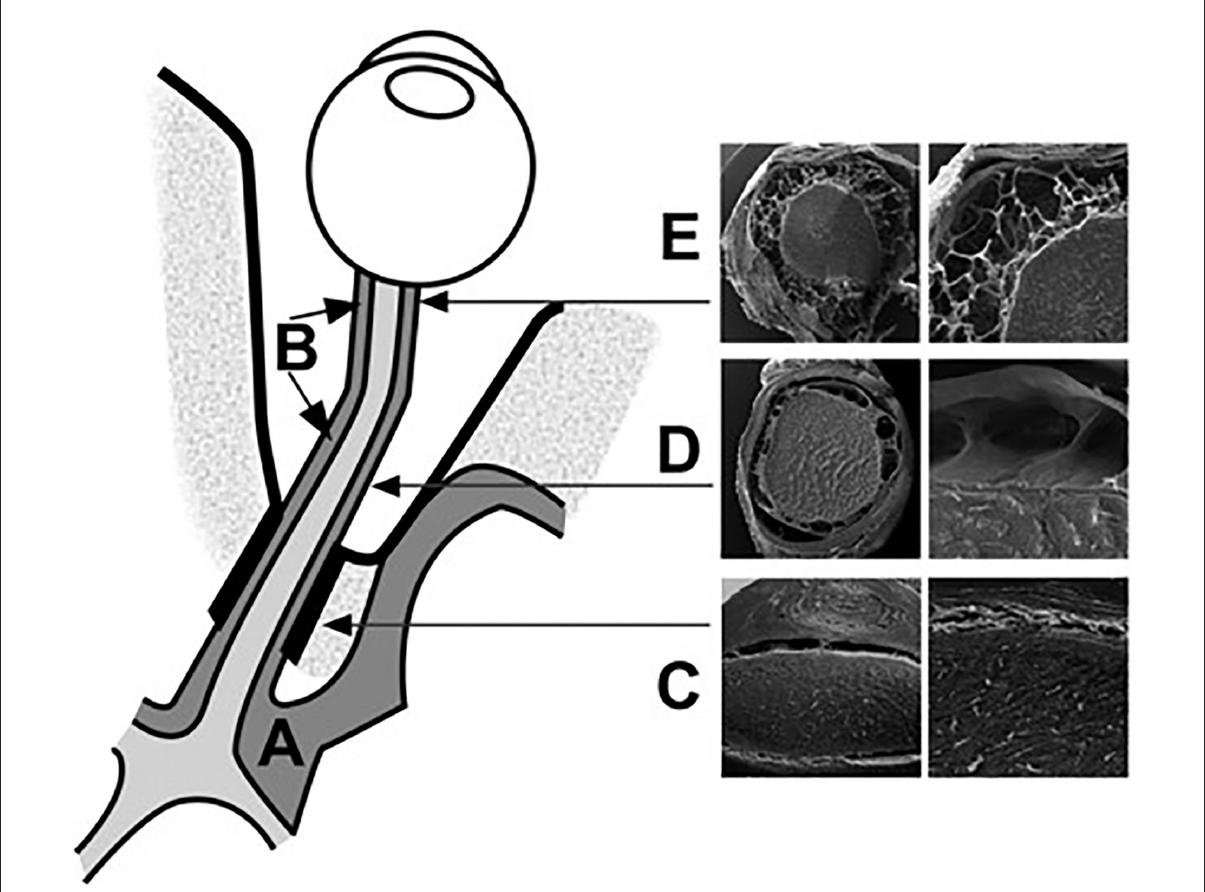
FIGURE4 Schematic representation of the CSF spaces surrounding the optic chiasm (A) and the ON (B) . The subarachnoid space at the intracanalicular region is the narrowest (C) . The intraorbital segment of the SAS is characterized by broad septae (D) . The retrobulbar segment is characterized by small trabeculae (E) . The bulbar segment from the intracranial SAS to the orbital SAS [Reproduced from Killer et al. (35) with permission from the